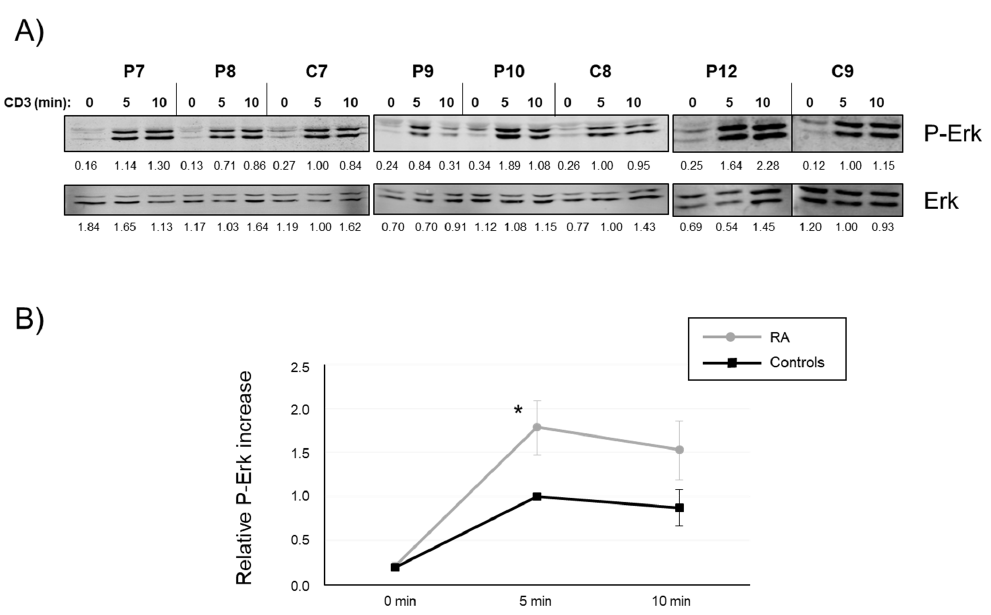
Figure 5. Increased Erk phosphorylation in CD4+ T cells from RA patients. ( A ) Purified CD4+ T cells from RA patients (P) and healthy controls (C) were cultured for 5 days in the presence of anti- CD3/CD28 beads and IL-2, and then stimulated with anti-CD3 mAb at 37 °C for the indicated times. Cell lysates were obtained and phosphorylation of Thr202 and Tyr204 residues in Erk was analyzed by Western blot using phospho-specific antibodies (top panels). Membranes were stripped and total Erk was analyzed to show total protein load (bottom panels). Three independent experiments are shown. Numbers below the panels represent the densitometric quantification of individual bands. ( B ) Graphics representing the quantification of five independent experiments with five healthy con- trols (black line) and nine RA patients (grey line). Phosphorylation levels were normalized to total Erk expression and the means of fold increase of phosphorylation with regard to non-stimulated cells were graphed. Bars represent the standard error. The asterisk represents statistical significance ( p < 0.05) using a two-tailed t -test. 3. Discussion RA is a chronic inflammatory disease affecting the synovium, leading to joint damage and bone destruction, and causes severe disability and increases mortality [17]. Prevalence studies of RA show a substantial variation of the disease occurrence among different pop- ulations, with a prevalence of 0.5–1.1% in Northern European and North American areas, and a relatively lower prevalence of in 0.1–0.5% in developing countries [17]. There is a consensus that RA is a multifactorial disease, resulting from the interaction of genetic and